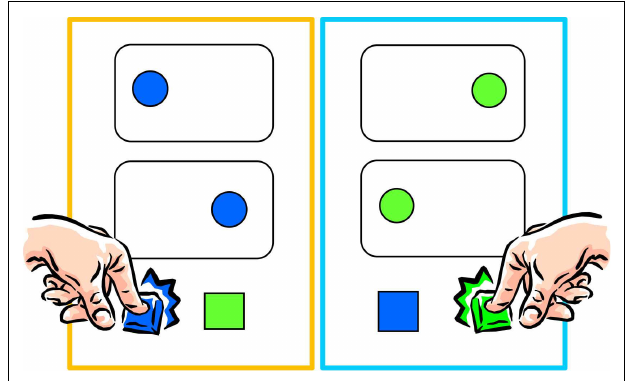
FIGURE 1 | Setting in the social Simon task: the task was distributed among two individuals. Each person responded to only one of the two